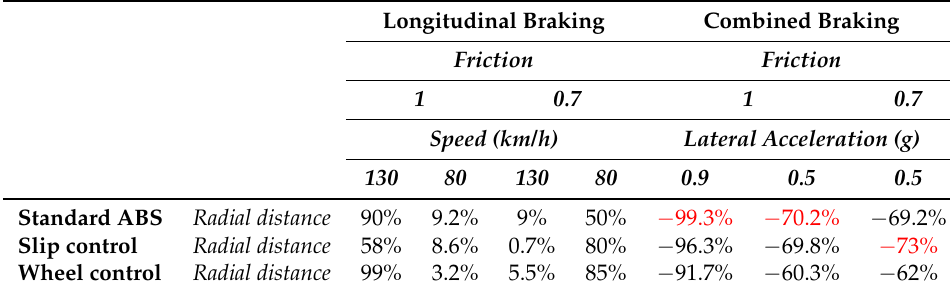
Table 4. Test results about radial distance